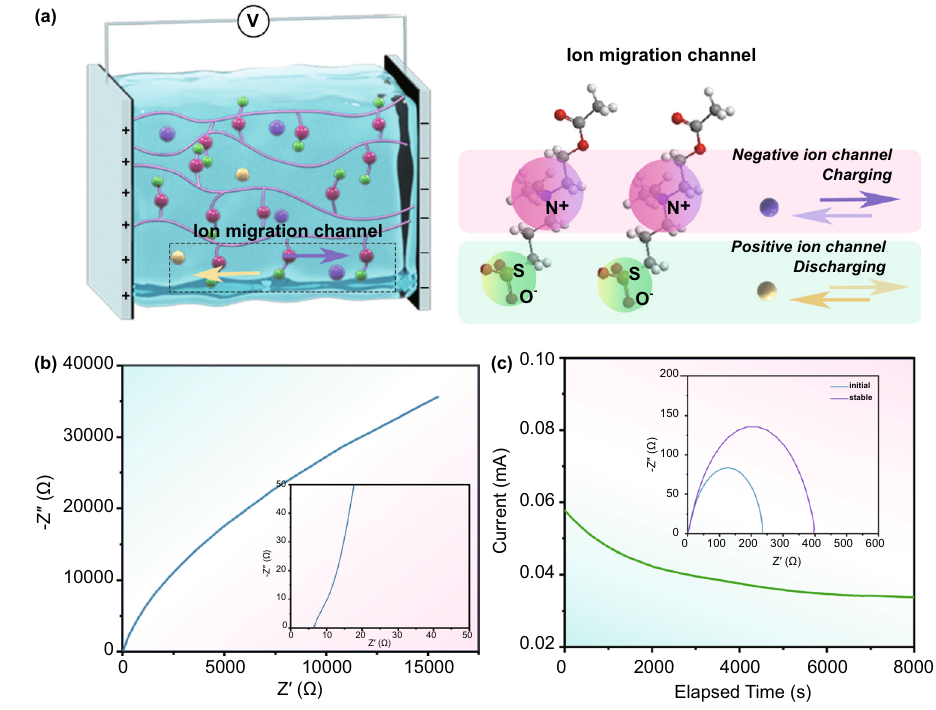
Fig. 2 a Schematic illustration of the construction of ion migration channel under the applied electric field. b EIS spectra of the ADC-gel with two blocked electrodes (stain steels). c EIS spectra and the current variation with the polarization of Zn/ADC-gel/Zn symmetric